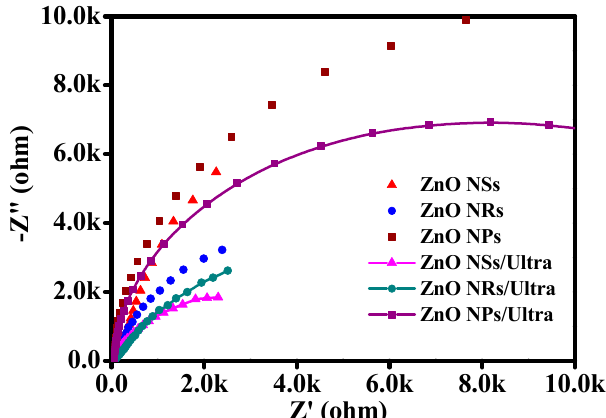
Figure 8. EIS of three ZnO samples without ultrasonic vibrations (Ultra) and with ultrasonic vibra- tions under illumination.